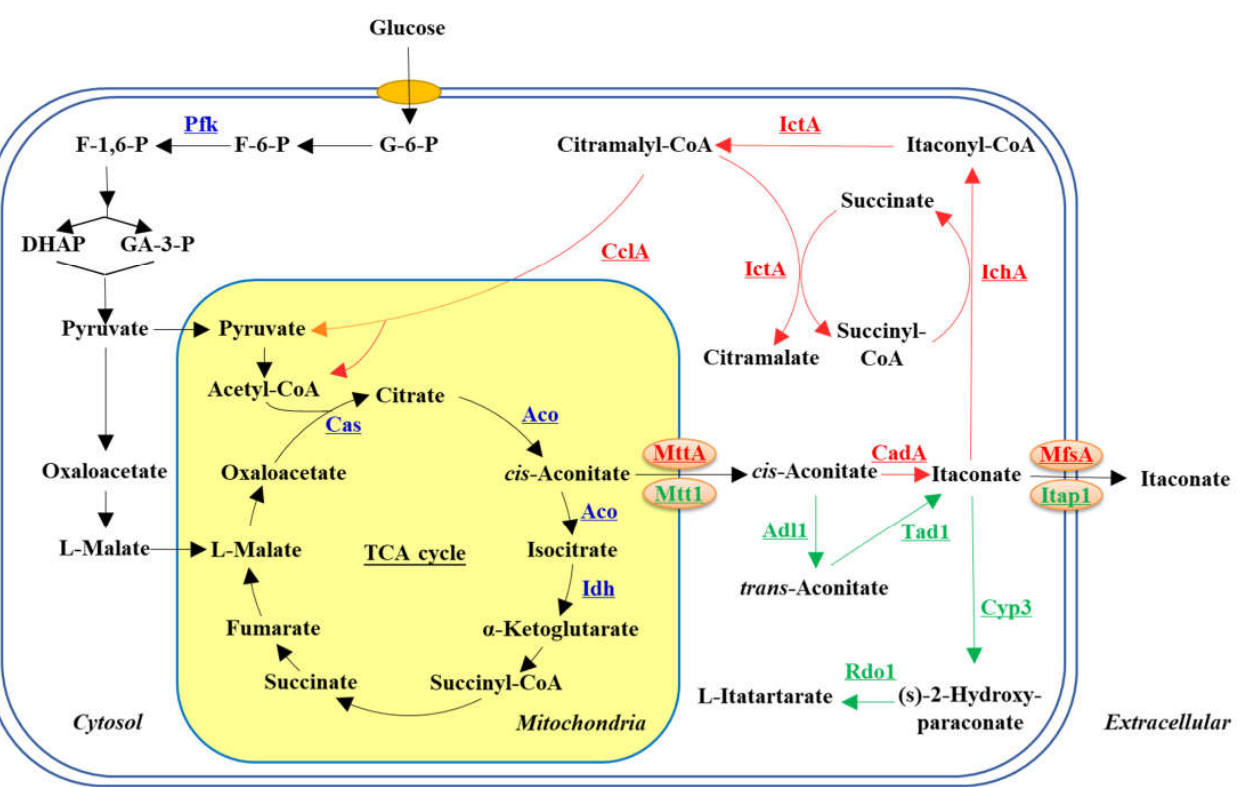
Figure 1. The synthesis and degradation pathways of ITA in microbes. Pfk, 6-phosphofructo-1-kinase; Cas, citrate synthase; Aco, aconitase; Idh, isocitrate dehydrogenase; CadA, cis-aconitase decarboxylase; MttA/Mtt1, mitochondrial tricarboxylate transport protein; Mfsa, major facilitator superfamily protein; IchA, itaconyl-CoA hydratase; IctA, itaconyl-CoA transferase; CclA, citramalyl-CoA lyase; Adi1, aconitate-Δ-isomerase; Tad1, trans-aconitate decarboxylase; Itap1, itaconate transporter protein; Cyp3, P450 monooxygenase; Rdo1, ring-cleaving dioxygenase; G-6-P, glucose-6-phoshate; F-6-P, fructose-6-phosphate; F-1,6-P, fructose-1,6-bisphosphate; DHAP, dihydroxyacetone phosphate; GA-3-P, glyceraldehyde-3-phosphate. The synthesis pathway identified in A. terreus was present in the red line, while that identified in U. maydis was present in the green line.